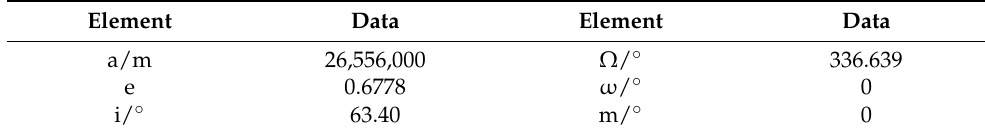
Table 3. Classical orbital elements of space debris from GEO band.